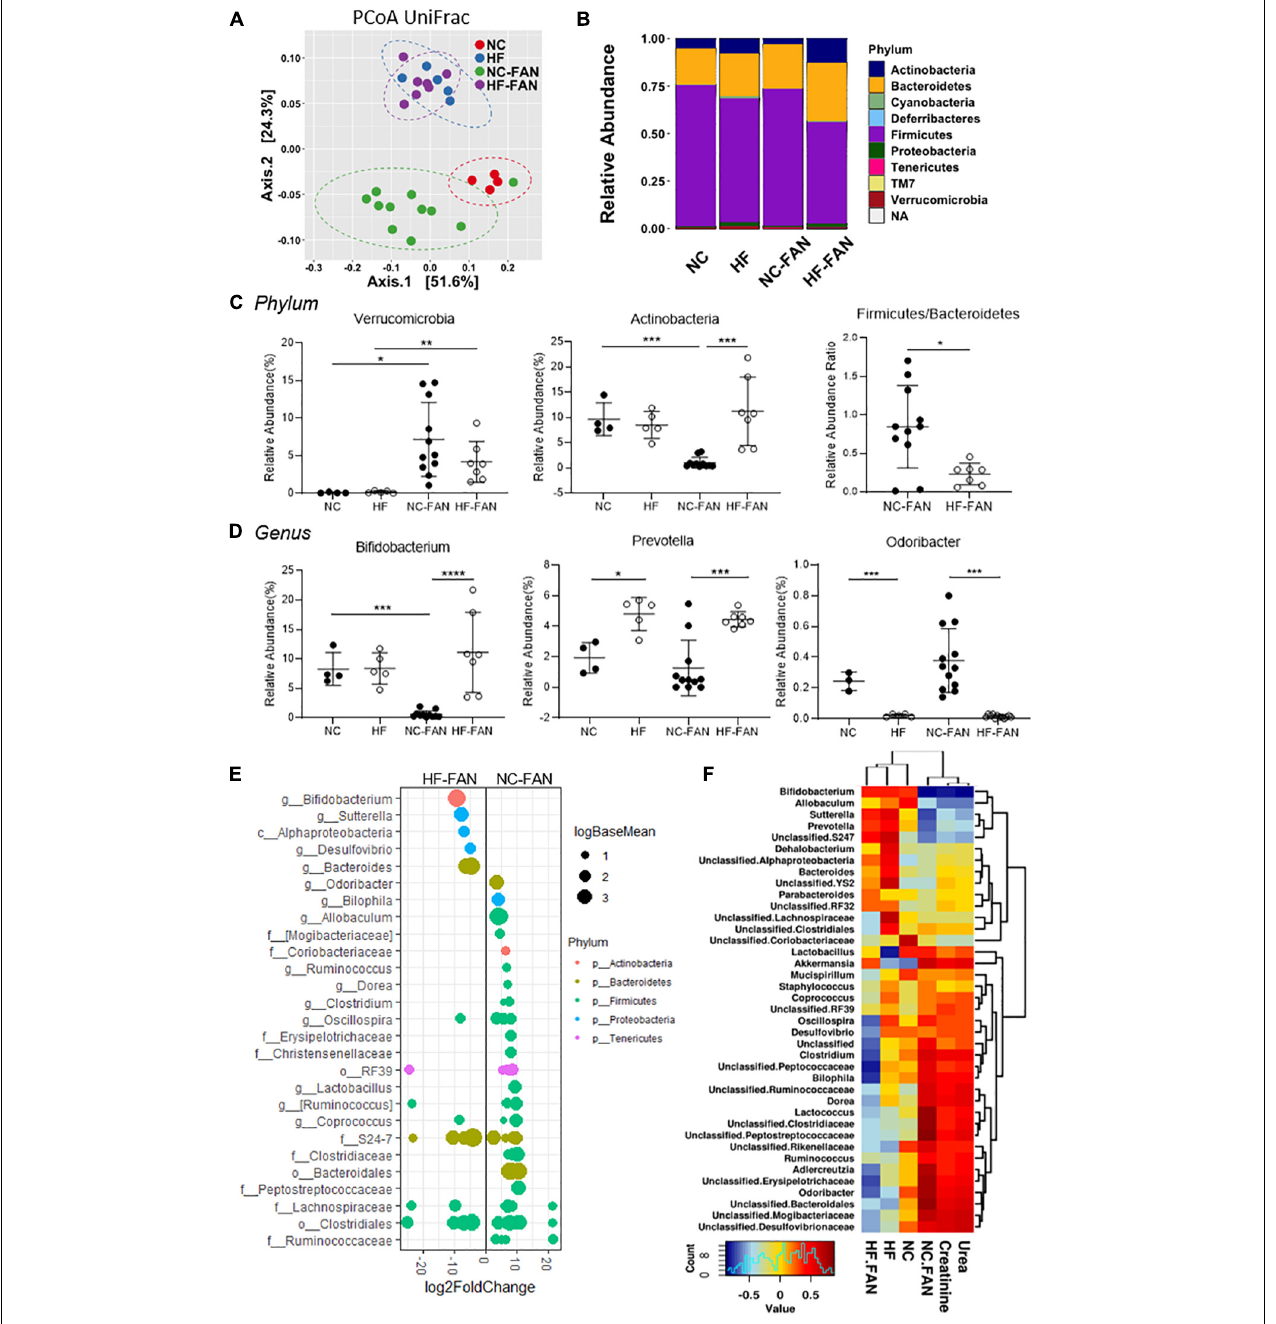
FIGURE 3 | High Fiber diet alters the gut microbial community structure and protects against FAN associated acute dysbiosis at day 2. Fecal DNA analysis using 16S rRNA sequencing was performed on mice fed a NC (FAN: n = 11; non-FAN: n = 4) and HF (FAN: n = 7; non-FAN: n = 5) diet at day 2 after FAN induction. (A) Principal coordinate analysis of the weighted Unifrac distances demonstrates significant modulation in the microbiota community with cluster separation between diet groups and mice with and without FAN. (B,C) Taxonomical composition and relative abundance of different bacteria by ANCOM analysis at the phylum level, depicting “dysbiosis” with expansion of Verrucomicrobia at the expense of Actinobacteria in NC fed mice, which was modulated by HF feeding. A HF diet suppressed the Firmicutes to Bacteroidetes ratio. (D) At the genus level, NC fed FAN mice had lower levels of the SCFA producers Bifidobacterium and Prevotella , with relative expansion of the pathobiont Odoribacter compared to those fed HF. (E) DESeq2 analysis demonstrating differential abundant OTUs (FDR adjusted P < 0.01) between dietary groups after FAN induction. OTUs were assigned to their lowest described classification ( y -axis) and color coded by phylum. Bubble size represents a log fold change in the log base mean of the recorded OTU, with the x -axis values demonstrating log2 fold change in relative abundance. (F) Pearson-correlation-based heatmap at a genus level, identifying the bacteria associated with increment of serum urea and creatinine. Cool colors represent negative correlation and hot colors represent positive correlations. Data are shown as means ± SD; * P < 0.05, ** P < 0.01, *** P < 0.001, **** P < 0.0001.